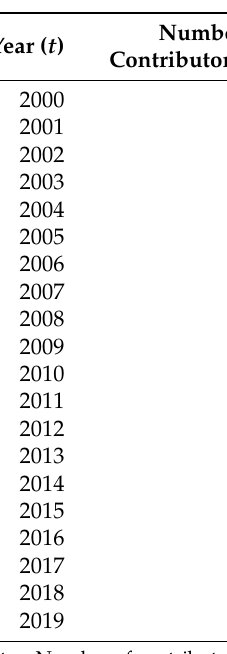
Table 1. Pension data in Spain.